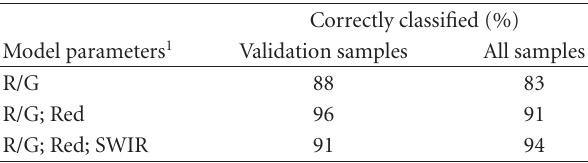
Table 4: Spectral wavebands of the SPOT5-HRVIR sensor. Table 5: Classification results (%age of individual trees that were correctly classified as infested or not infested with the adelgid) obtained from the discriminant analysis procedure. Results in the validation samples column were generated by applying the discriminant function developed from a randomly selected training data set to the remaining 33% of the observations ( n = 68). Results in the all samples column were generated by applying the discriminant function developed using the entire data set of 206 trees sampled during the study.